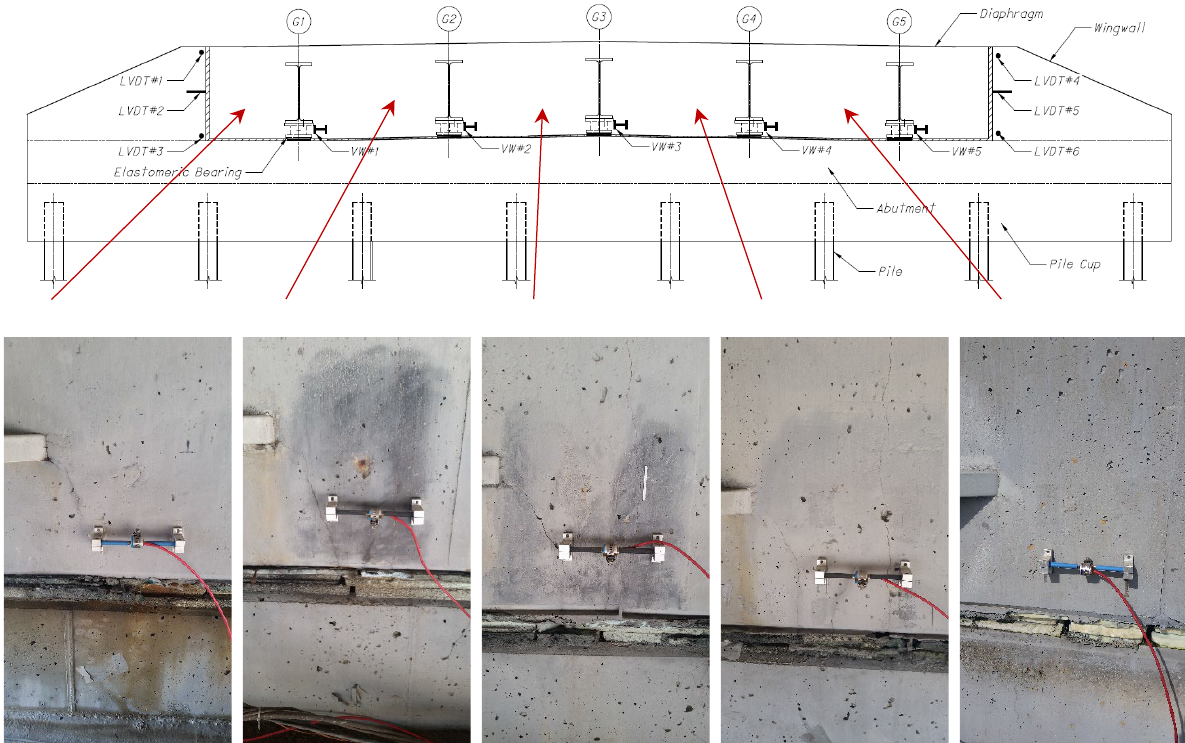
Figure 2. Instrumentation Layout and Strain Gauges Located at Girders. The LVDTs were placed at the interface between the sides of the wing walls and the sides of the end diaphragm to measure the relative displacement between them. The displacement of the end diaphragm is not the absolute movement of the superstructure, but rather the measured relative displacement between the superstructure and substructure of the bridge. LVDTs (#1, #3, #4, and #6) were placed near the top and bottom of the end diaphragm on both sides of the foreword abutment to measure the longitudinal displacement of the bridge superstructure. To measure the transverse movement of the bridge superstructure, LVDTs (#2 and #5) were placed on both ends of the end diaphragm parallel with the face of the bridge abutment. Figure 2 shows the locations of the LVDTs on the foreword abutment of the bridge. Figure 3 shows LVDTs #1, #2, and #3, located on the obtuse corner of the foreword